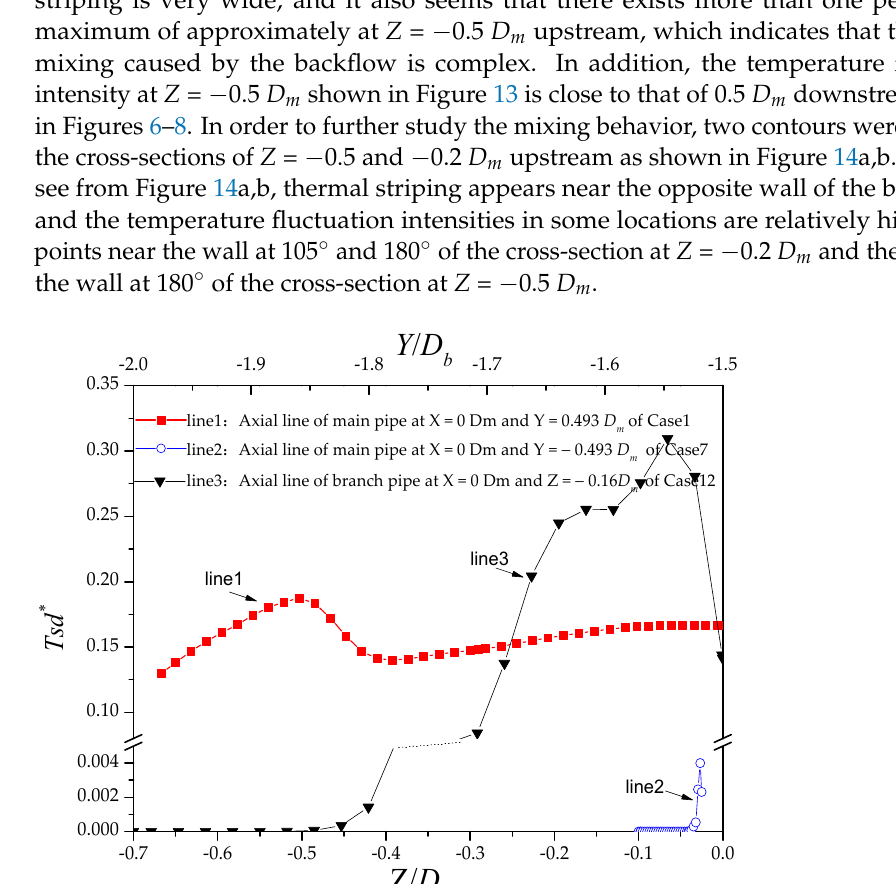
Figure 14. Temperature distribution upstream (the upper figures show temperature T * distribution and the lower figures show temperature T sd* distribution): ( a ) A cross-section at Z = − 0.2 D m in case1; ( b ) a cross-section at Z = − 0.5 D m in case1; ( c ) a cross-section at Z = − 0.18 D m in case7; ( d ) a cross- section at Z = − 1.55 D b in case12.